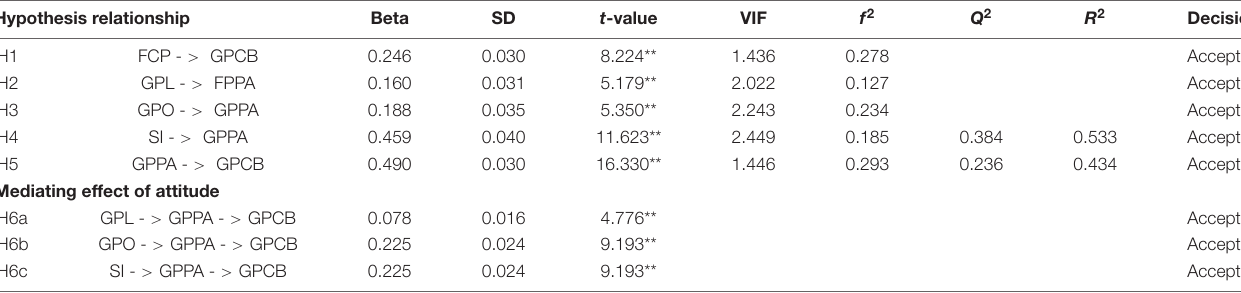
TABLE 3 | Path coefficients.